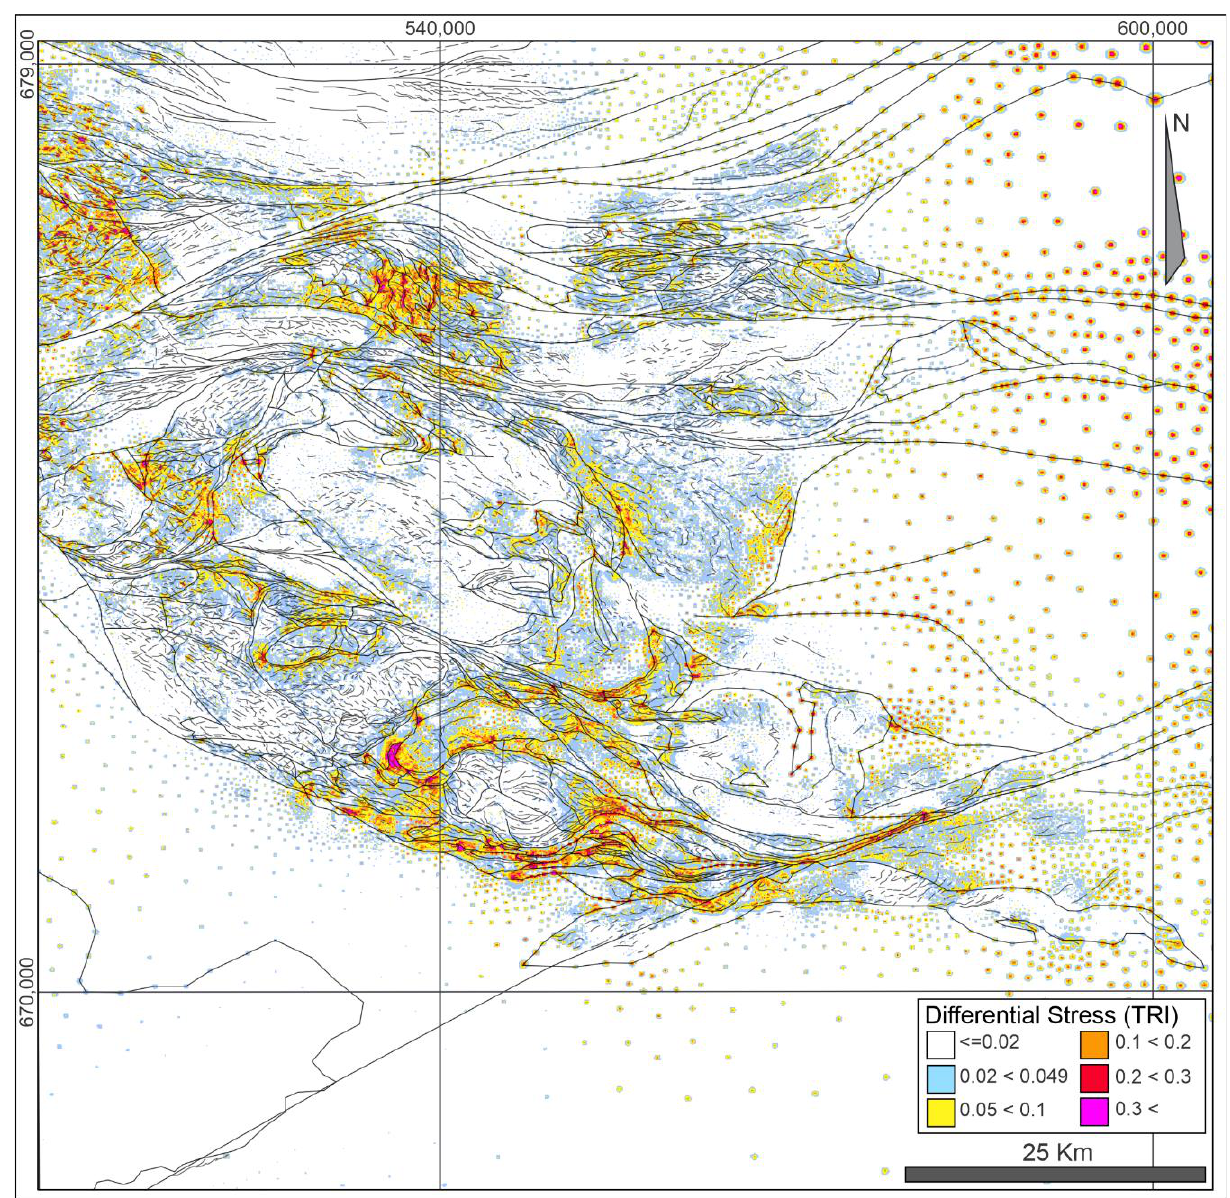
Figure 9. Differential stress, shown as a Terrain Ruggedness Index (TRI) map, showing spatial heterogeneity across the Mt. Woods Inlier. Warmer colours indicate high changes in differential stress while cooler colours indicate lower changes in differential stress. Areas of particularly high differential stress occur around the large gabbro-gabbrodiorite body in the southern extent of the Mt. Woods Inlier, with another notable zone to the north of the Cairn Hill Shear Zone.